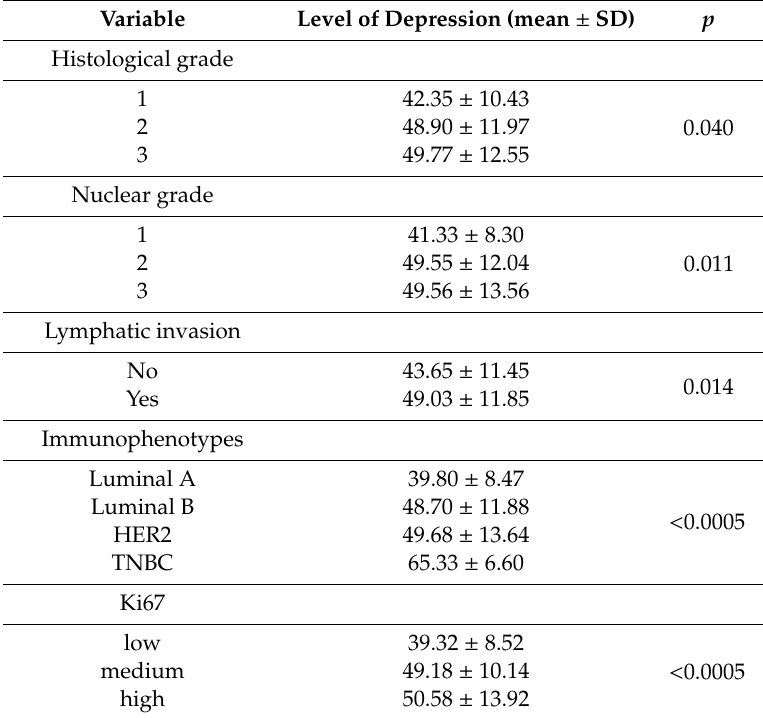
Table 2. Depression level according to clinical and pathological